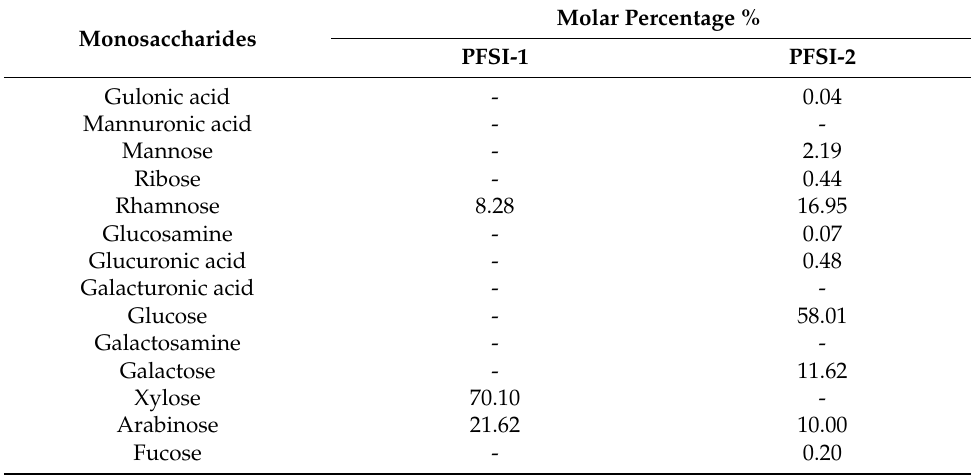
Table 1. Molar percentages of monosaccharide components of PFSI-1 and PFSI-2. (Note: - represents no